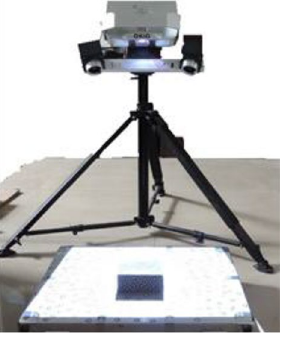
Figure 5. 3D scanning device for rock structure